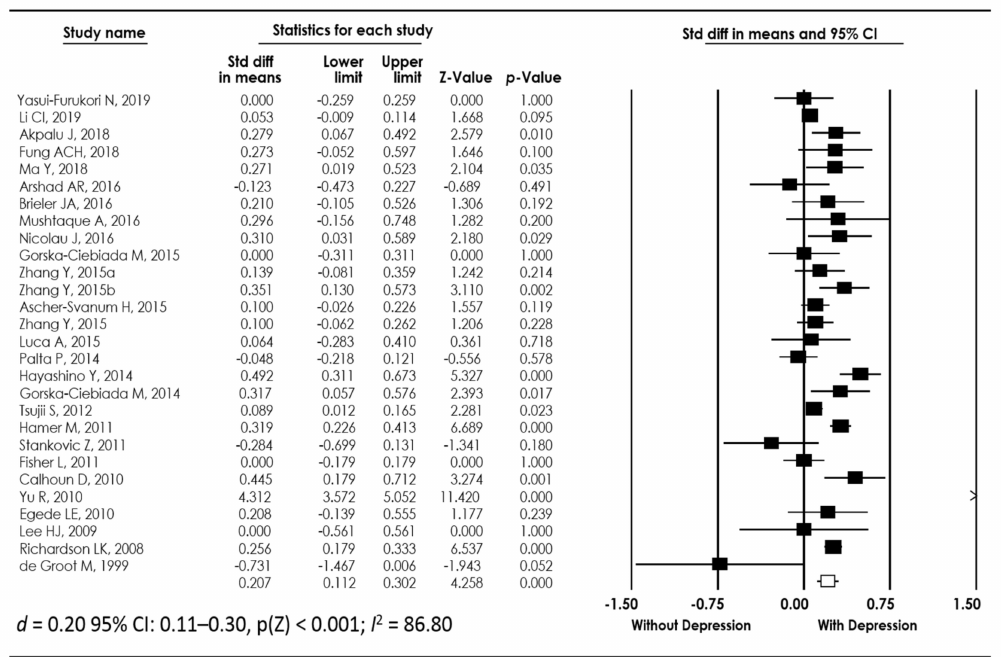
Figure 3. Forest plot of the meta-analysis for HbA1c levels in individuals with type 2 diabetes mellitus